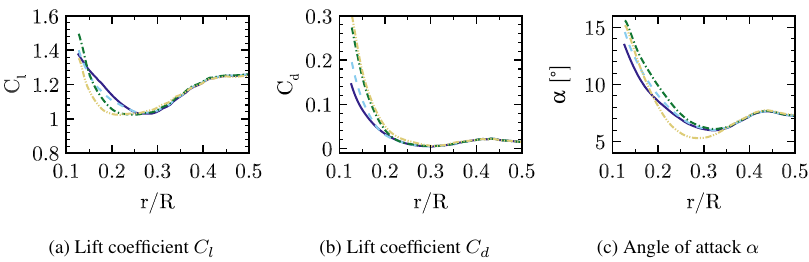
Figure 22. Aerodynamic coefficients along the blade radius for CaseT1.0 (solid), CaseT1.2 (dashed), CaseT1.4 (dashed dot) and CaseT1.4-twistmod (dashed dot dot).